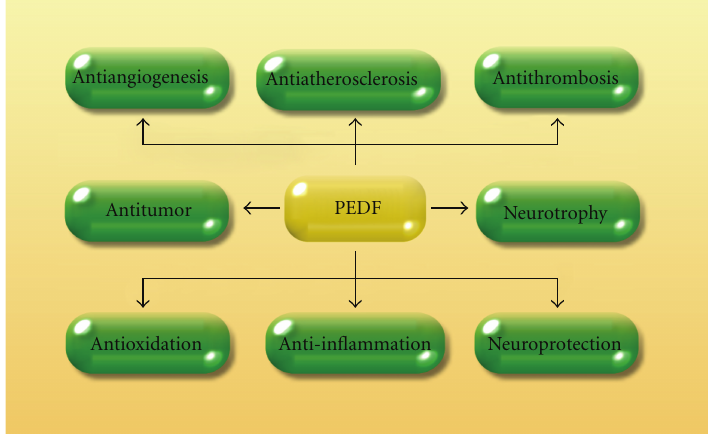
Figure 1: The medicinal properties (antiangiogenic, antiatherosclerosis, antitumorigenic, antioxidant, anti-inflammatory, antithrombotic, neurotrophic, and neuroprotective properties) of PEDF.